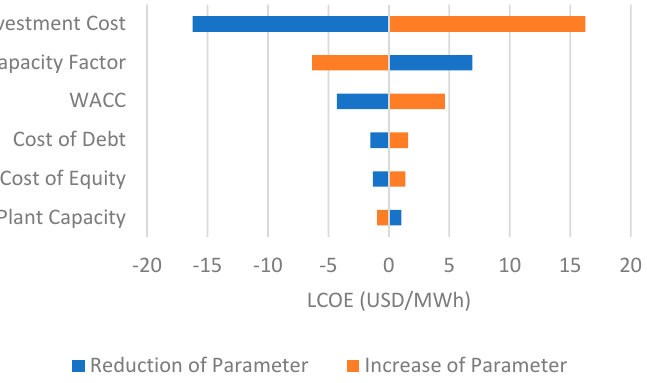
Figure 31. Sensitivity analysis of LCOE to different parameters (SWT-3.6-120).